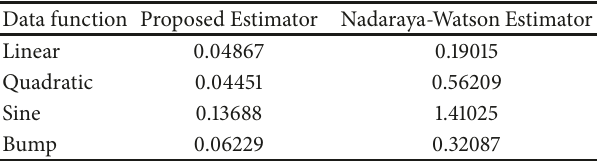
Table 3: Summary results of MSEs.